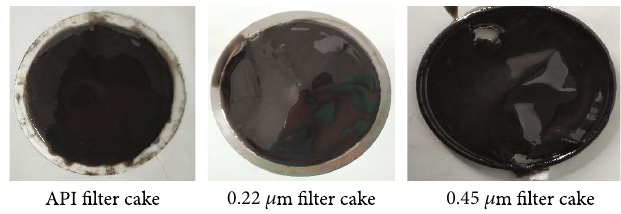
Figure 5: Picture of plugging agent YX1200 mud